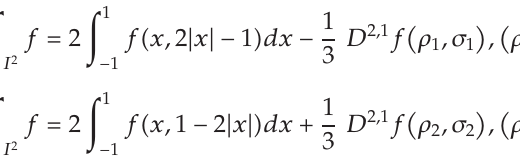
(cid:3) x,y (cid:4) and h ∗ f